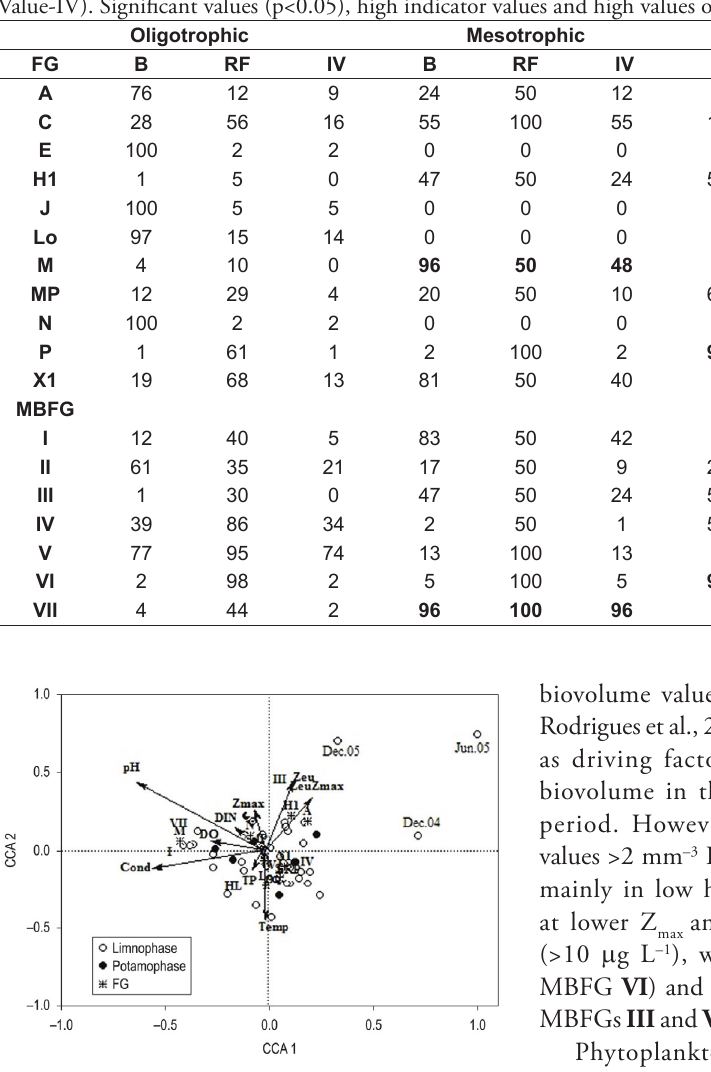
Figure 5. Scores dispersion of FGs phytoplankton of Corutuba channel in the first two CCA axes in lim- nophase and potamophase periods (Temp – Water temperature; TP – Total phosphurus; SRP – Soluble reactive phosphurus; DIN - Dissolved inorganic nitrogen; Cond – Eletrical condutivity; DO – Dissolved oxygen; pH – pH; Z - Maximum Depth; Z - Euphotic zone; max eu Z .Z - Relation Euphotic zone. Maximum Depth; eu max HL - Hydrometric